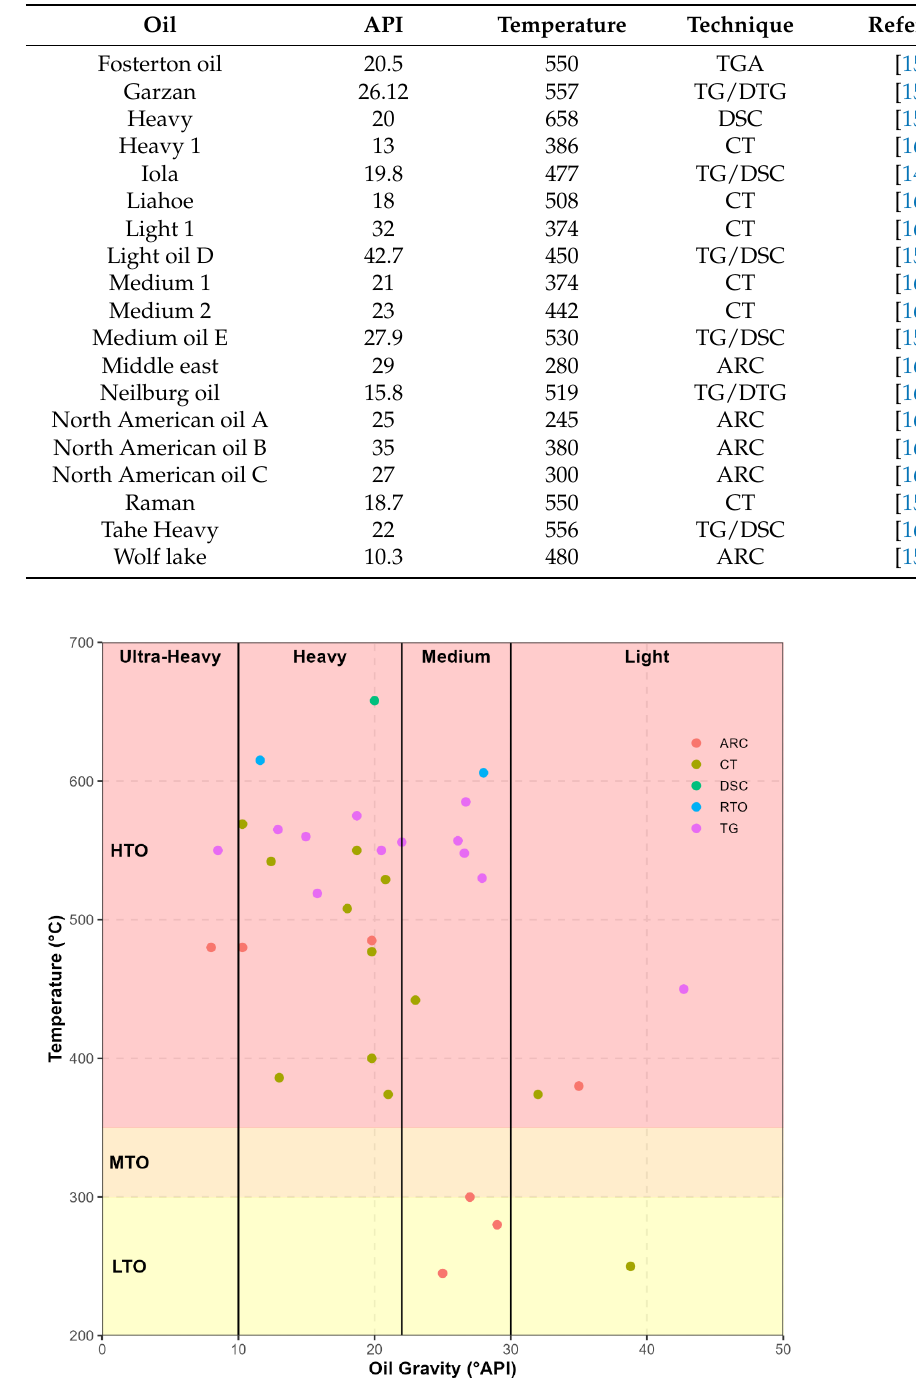
Figure 7. Cross plot of oil gravity versus temperature for experimental data from the literature (Ta- ble 2), with light, medium heavy and extra heavy oil divisions and low temperature oxidation (LTO), medium temperature oxidation (MTO), and high temperature oxidation (HTO) zones marked. Data are coloured by experimental method, Thermogravimetry (TG), Differential Scanning Calorimetry (DSC), Accelerated Rate Calorimetry (ARC), and Combustion Tube (CT). Combustion tube data show a correlation between oil gravity and temperature, with higher temperatures